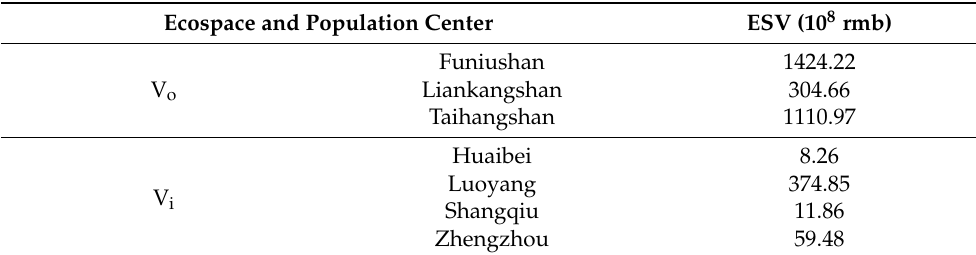
Table 6. ES amount of ecospace and city (population center